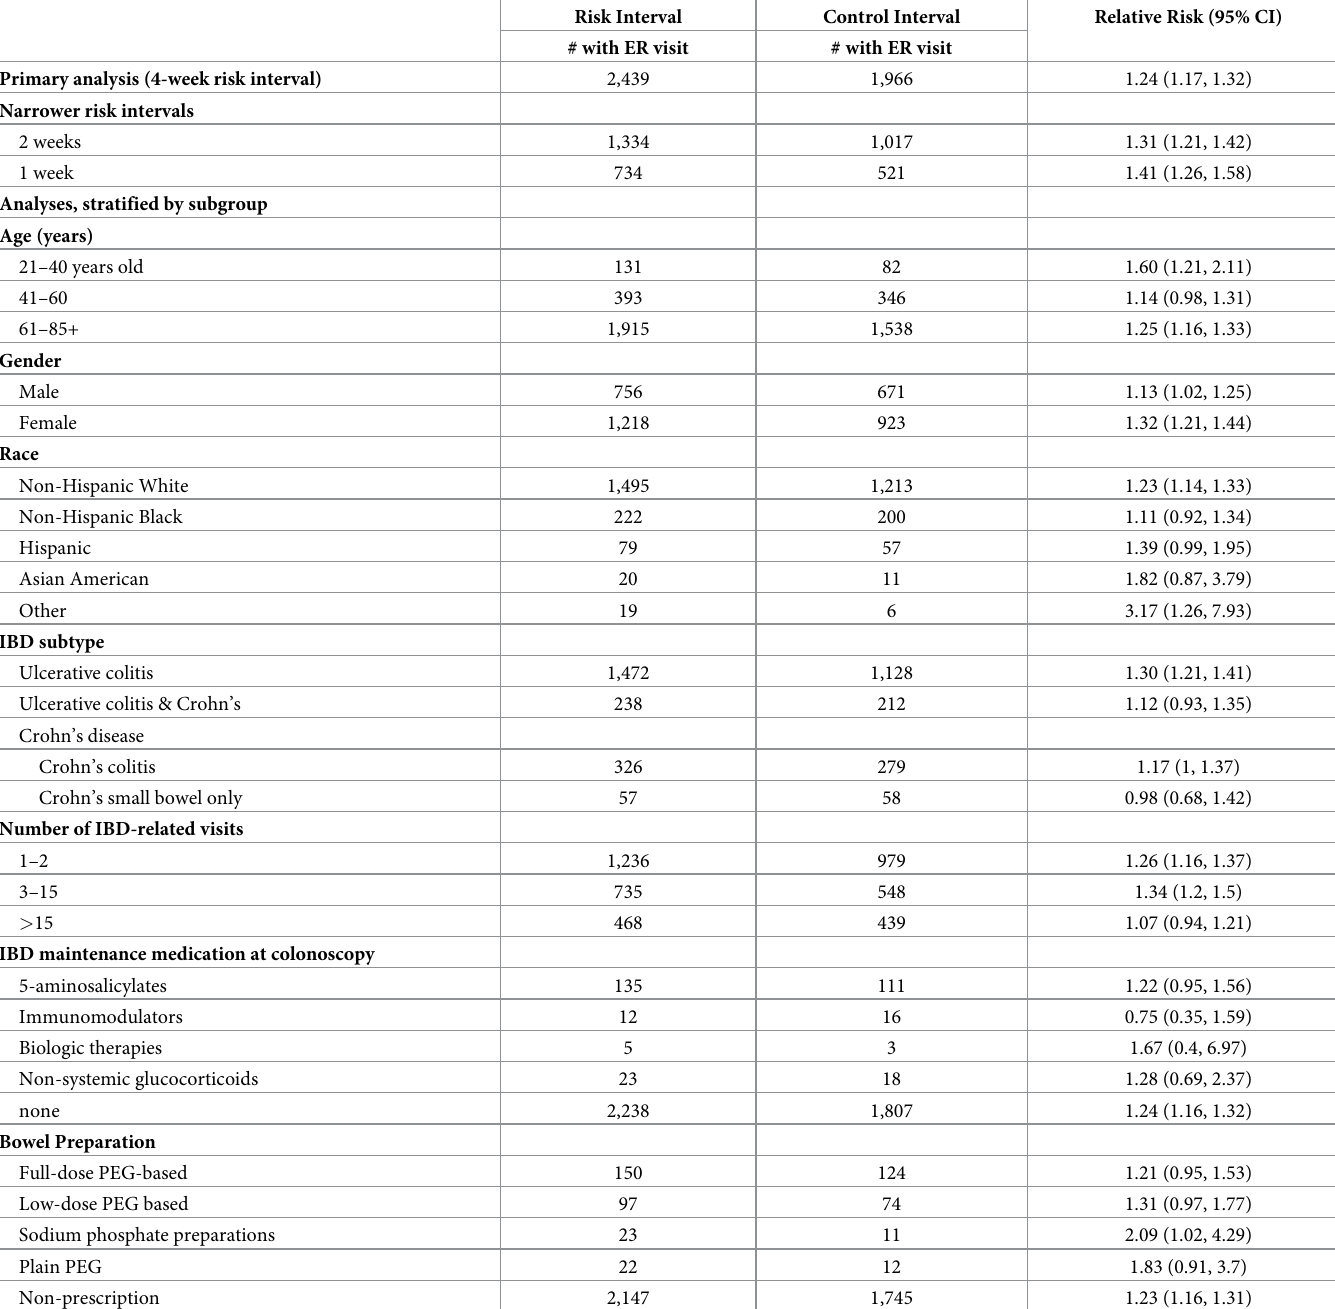
Table 2. Relative risk of ER visits after colonoscopy comparing risk and control intervals among IBD patients in the MPCD 2007–2010. Risk Interval Control Interval Relative Risk (95% CI) # with ER